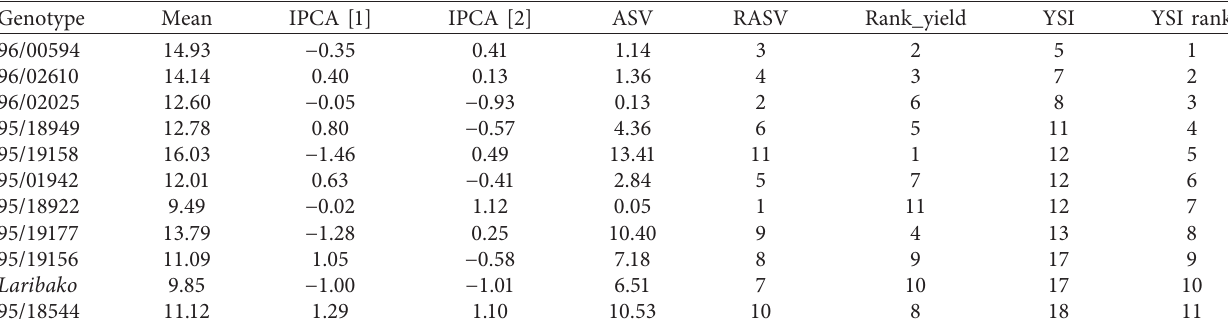
Table 5: Ranking of 11 yam genotypes based on tuber yield, AMMI stability value, and yield stability index in five environments. Genotype